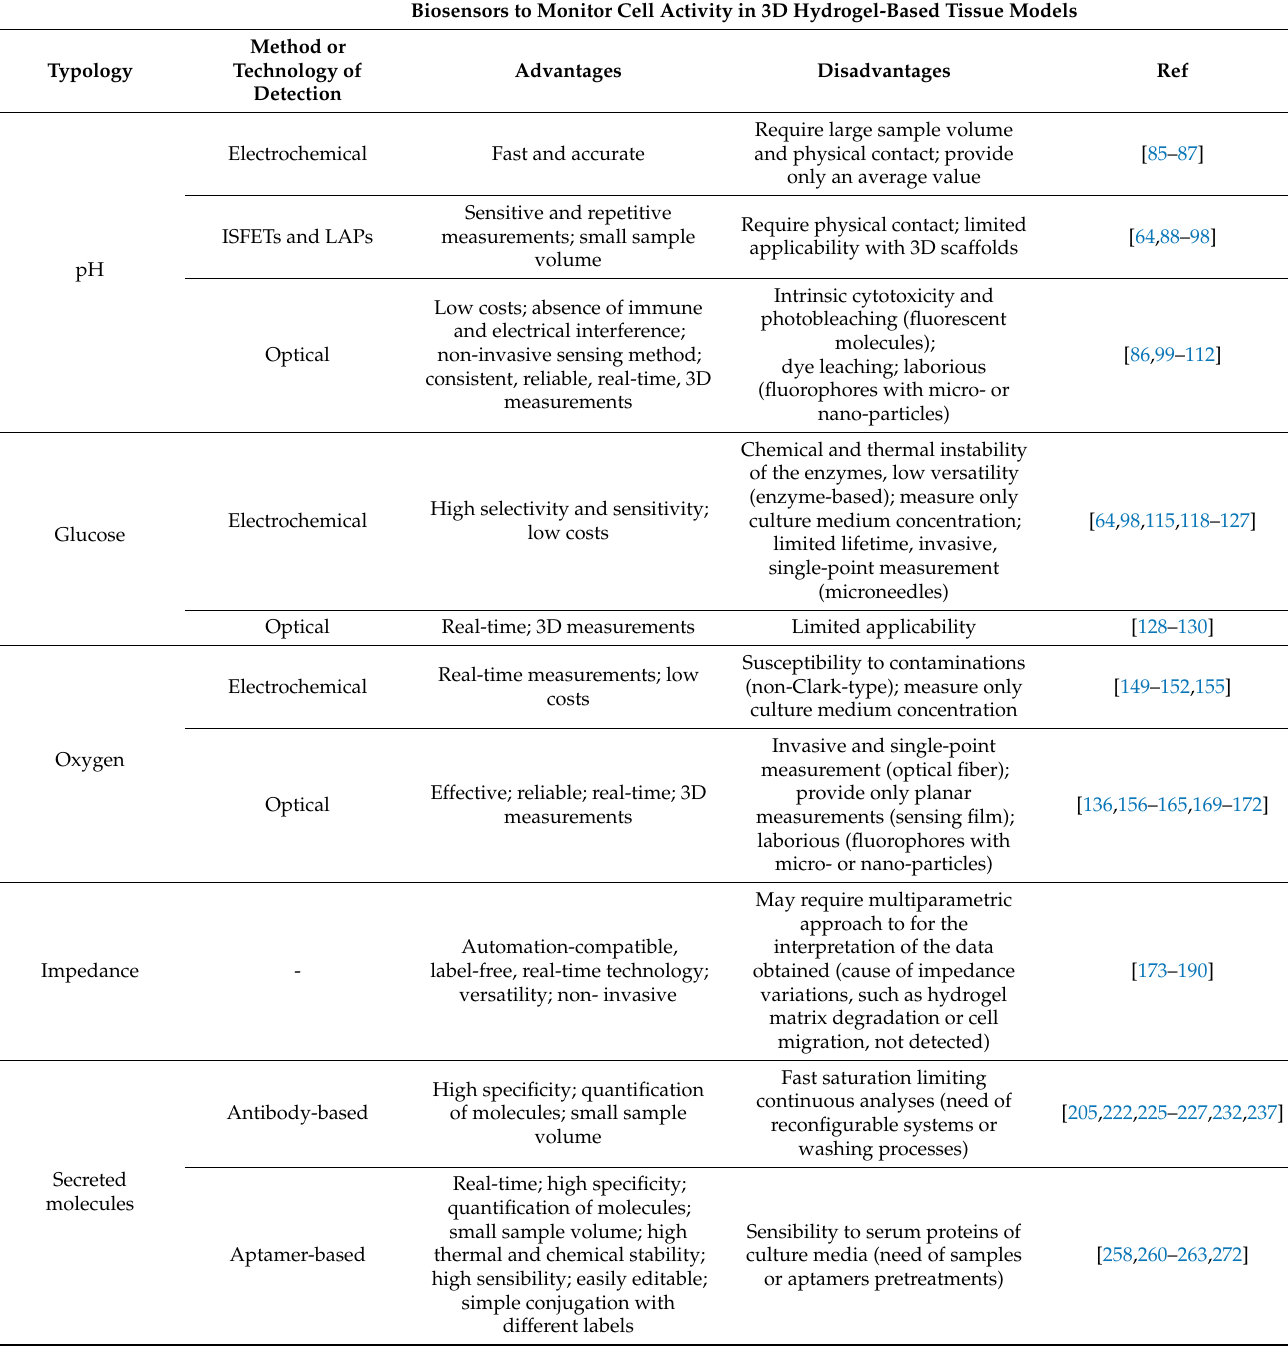
Table 2. Summary of the biosensors analyzed in the current review with their main advantages and